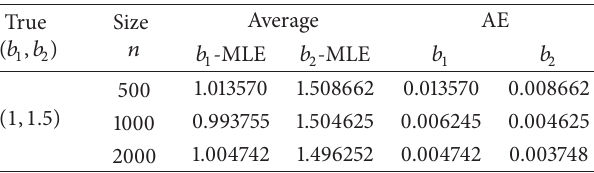
Table 2: The simulation values of the MLE of (𝑏 1 , 𝑏 2 ) when Δ𝑡 = 0.1 .